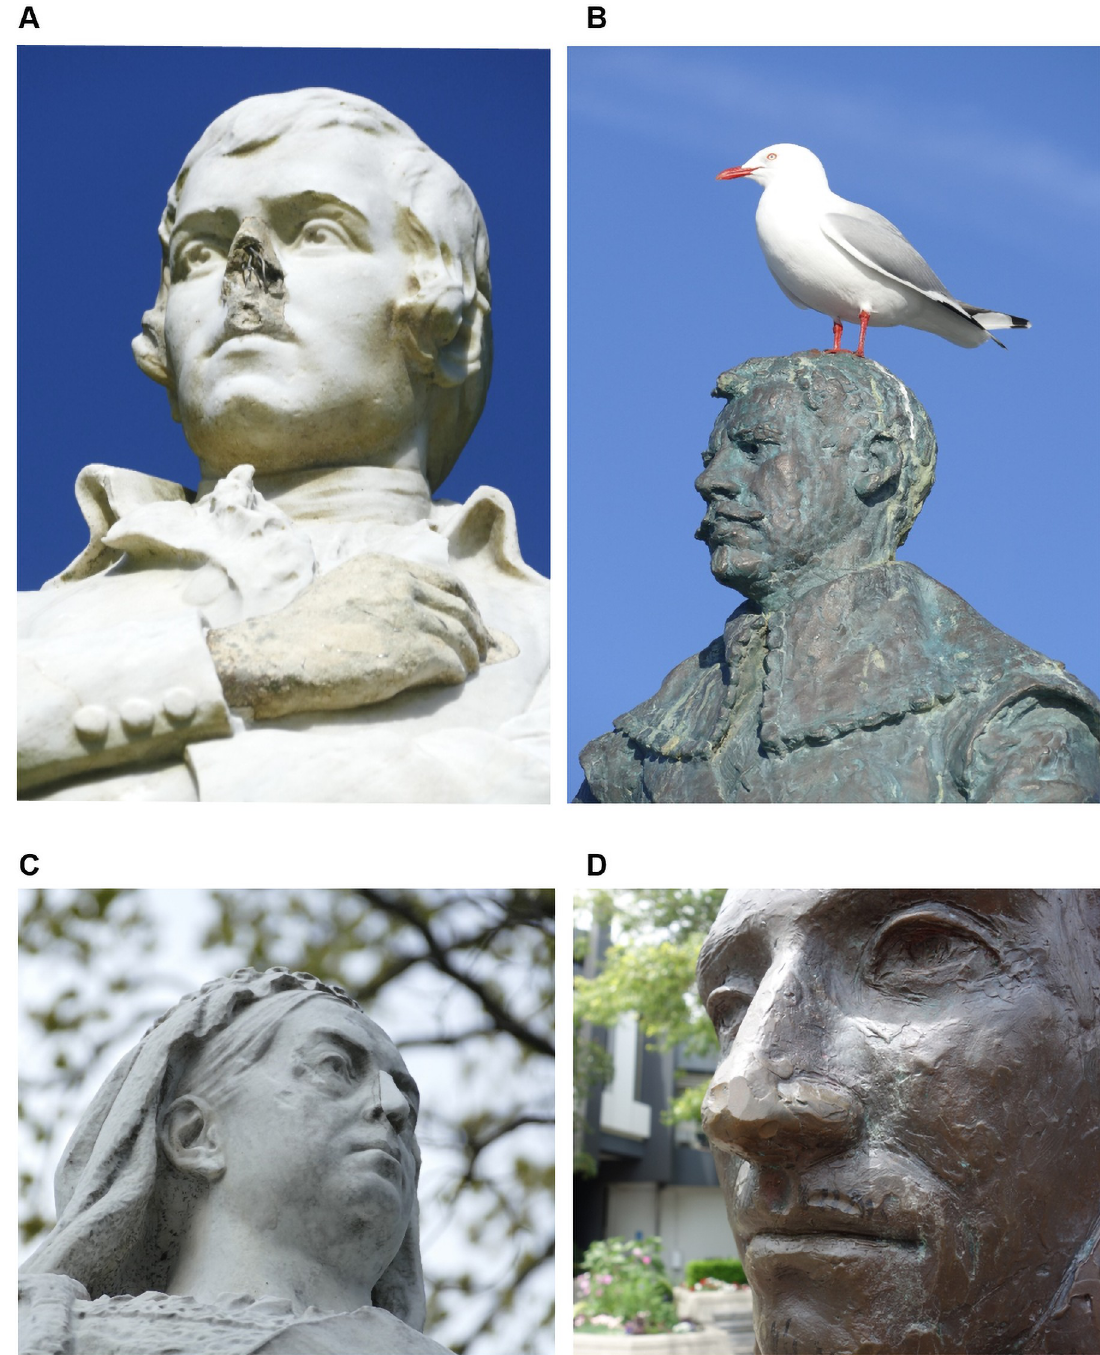
Fig 2. Examples of statues. Panel A: Statue of the poet Robbie Burns (Hokitika) showing nose damage and suboptimal hand repair. Panel B: Statue of an explorer Abel Tasman whose expedition killed M ā ori when arriving in New Zealand. Panel C: Statue of Queen Victoria (Dunedin) with a suboptimal nose repair. Panel D: Dented nose from an attack with a hammer on a statue of Captain Hamilton (Hamilton City); (all photographs by the 2 nd author, 2018/2019).